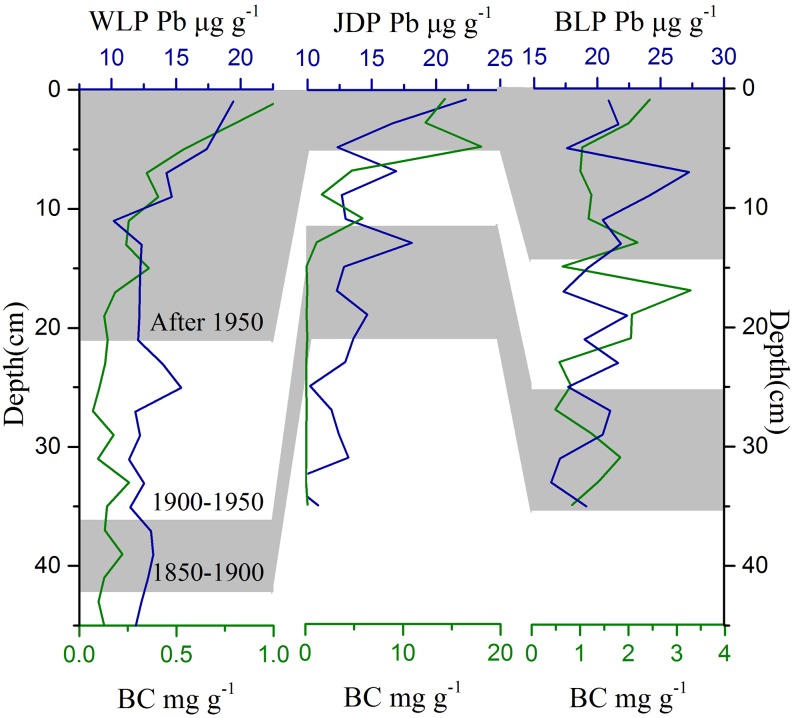
Variation of BC contents (green line) and Pb contents (blue line) with the soil depth in three profiles.Age-depth model was obtained by CRS model and divided into three periods (before 1900, 1900–1950, and after 1950).